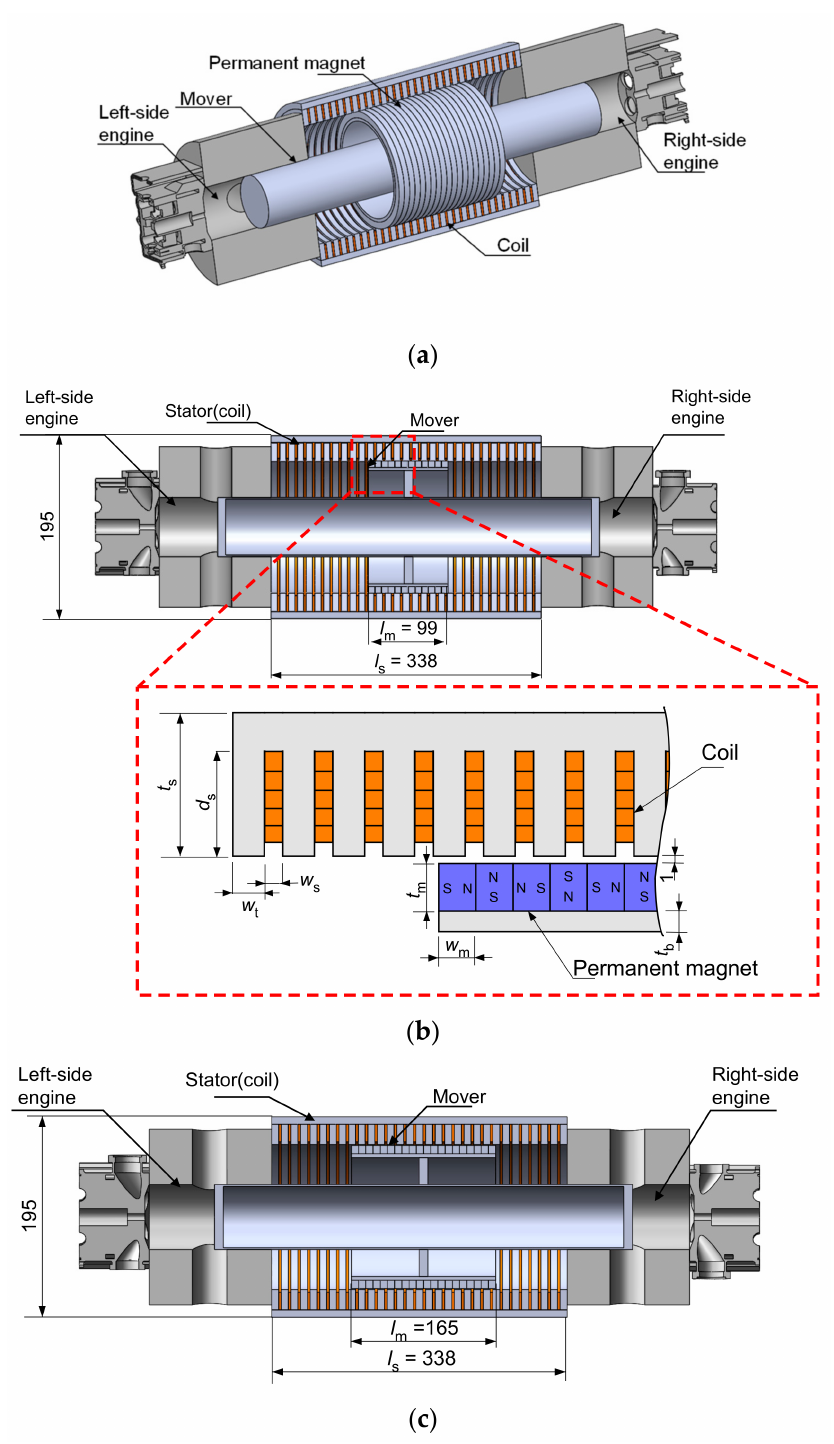
Figure 10. Structure of the dual-engine-type FPEG (unit: mm): ( a ) overview, ( b ) cross-sectional configuration of procedure I, ( c ) cross-sectional configuration of procedure